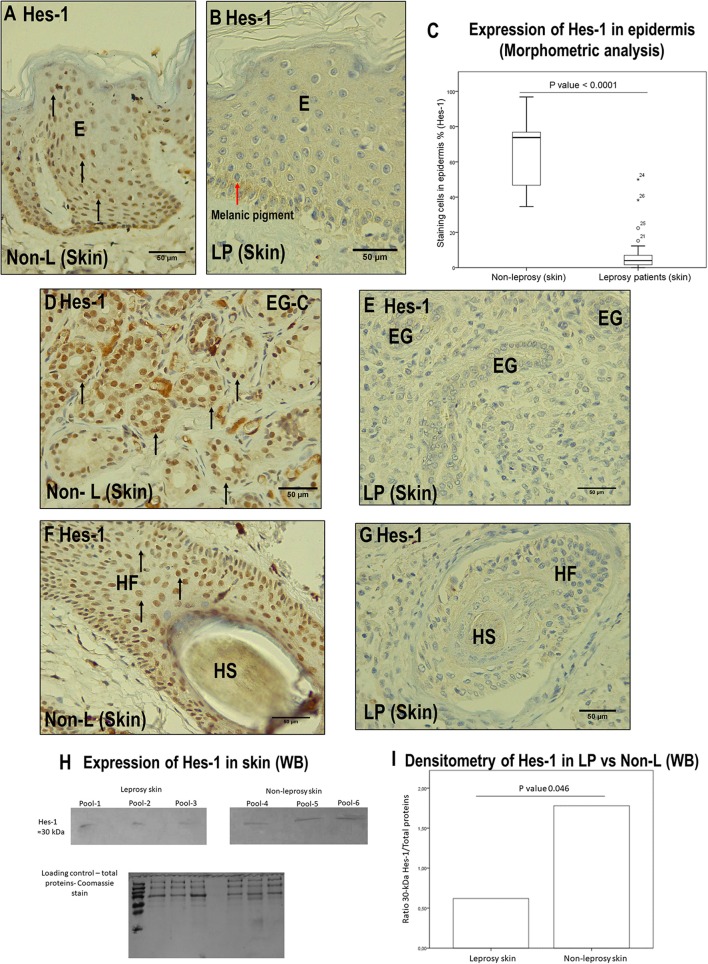
Comparison between leprosy skin and non-leprosy skin using immunohistochemistry with Hes-1 in the epidermis, eccrine glands, and hair follicles. (A) Epidermis (E) of a non-leprosy sample (non-LP) positive for Hes-1 in the Malpighian layer. (B) Epidermis (E) of a leprosy sample (LP) negative for Hes-1. The red arrow shows melanic pigment. (C) Whisker box chart showing a lower expression of Hes-1 in the epidermis of leprosy patients vs. non-leprosy patients, p < 0.0001. (D) Conglomerate of eccrine glands (EG-C) in a non-leprosy sample (non-LP) positive for Hes-1. (E) Three eccrine glands (EG) in a leprosy sample (LP) negative for Hes-1. (F) Hair follicle (HF) and hair shaft (HS) in a non-leprosy sample (non-LP) positive for Hes-1. (G) Hair follicle (HF) and hair shaft (HS) in a leprosy sample (LP) negative for Hes-1. (H) Western blot showing the bands for Hes-1 in leprosy skin, non-leprosy skin, and loading control (total proteins stained with Coomassie). (I) Densitometry showing a lower expression of Hes-1 in leprosy patients vs. non-leprosy patients, p < 0.05. All images have a 50-μm scale bar.